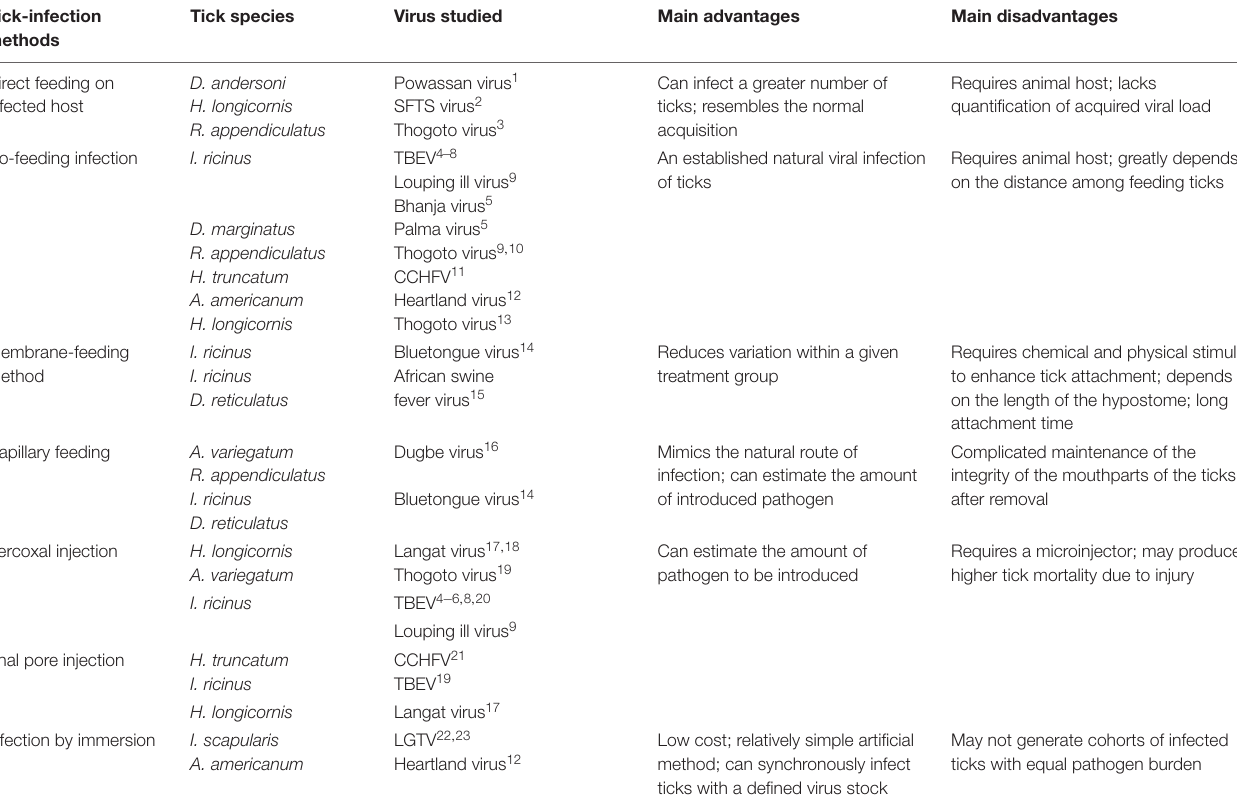
TABLE 1 | Summary of the techniques used to artificially infect ticks with representative ticks and viruses, their major advantages/disadvantages and associated references. Tick-infection Tick methods